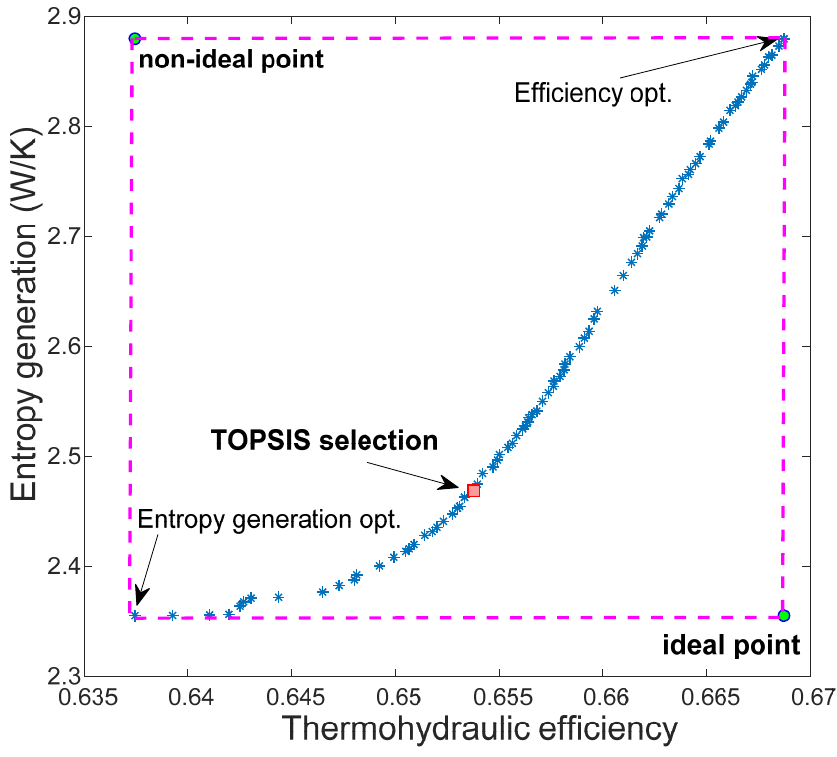
Figure 13. Pareto front and ultimate optimum solution selected by TOPSIS decision-making process.